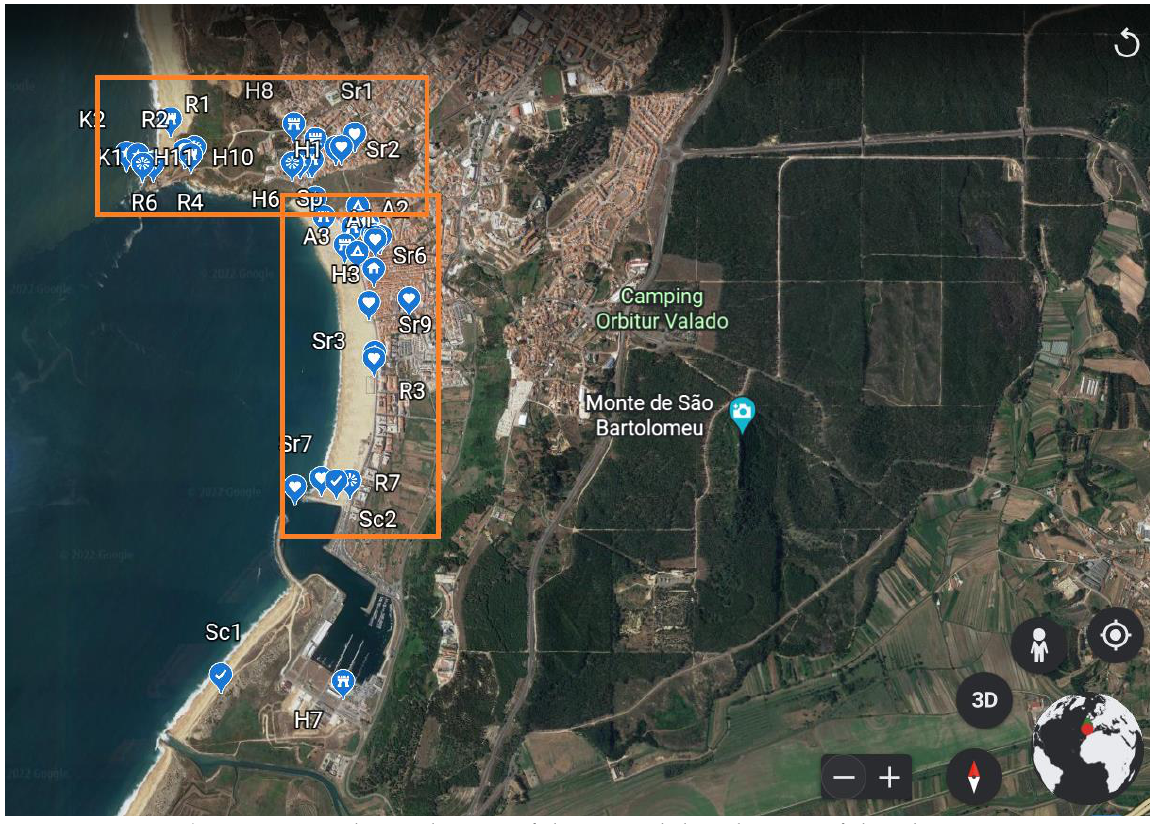
Figure 5. Google Earth map of the spatial distribution of the photos.